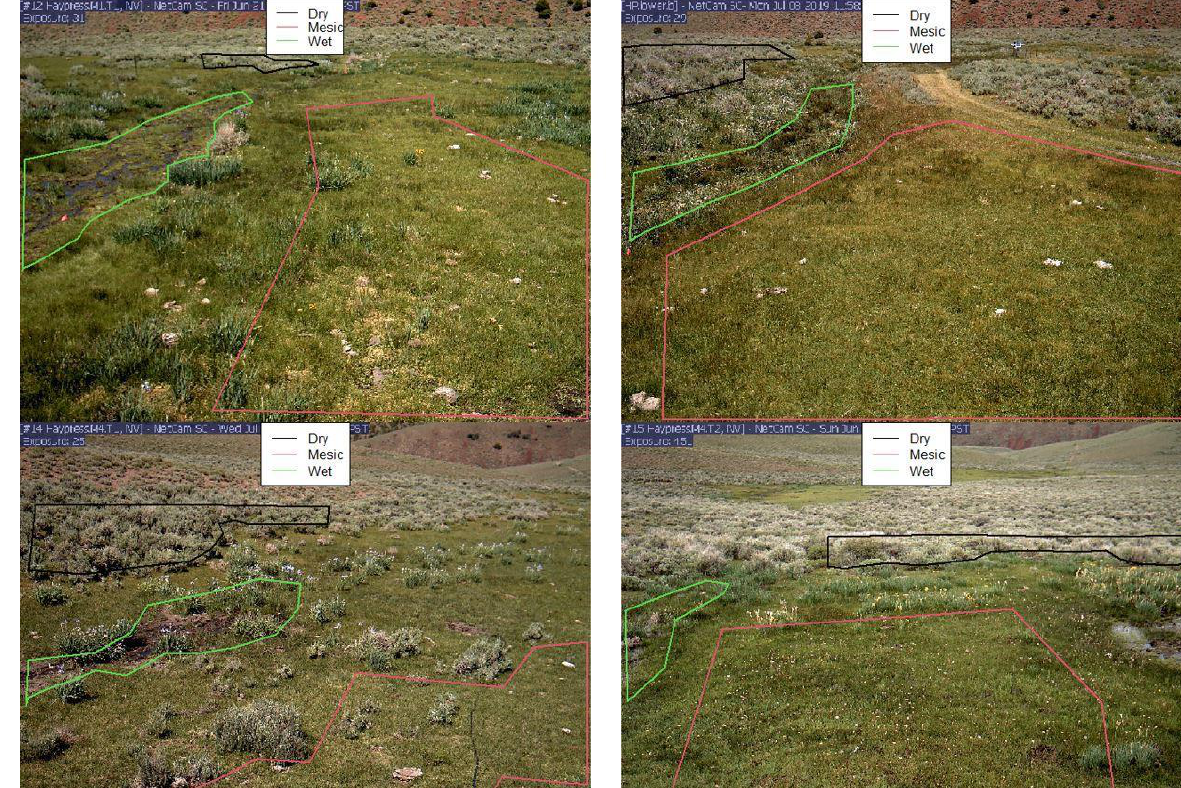
Figure 4. Examples of phenocam regions of interest (ROIs) for dry, mesic, and wet vegetation communities in the Haypress Meadow complex in the Desatoya Mountains, Nevada, U.S.A. A statistically significant difference in DOY for SD, DD, and RD phenophases was found across both vegetation community type and year, however not for meadow or grazing – year interaction. For the UD phenophase, significant differences were only seen across years (Table 3). The mean difference between 2019 and 2020 was highest for the DD phenophase ( − 42.13) and lowest for the UD phenophase ( − 14.13). A Tukey post-hoc test revealed significant pairwise differences only for the SD mesic-dry comparison in 2019. In 2020, community differences were seen for mesic-dry and mesic-wet comparisons across all phenophases except UD (Figure 5). No differences between wet-dry communities were statistically significant in either 2019 or 2020. Table 3. P-values for vegetation community types, years, meadows and grazing interactions derived from factorial ANOVAS, across all phenophases. Phenophase stages are upturn date (UD), stabilization date (SD), downturn date (DD), and recession date (RD).